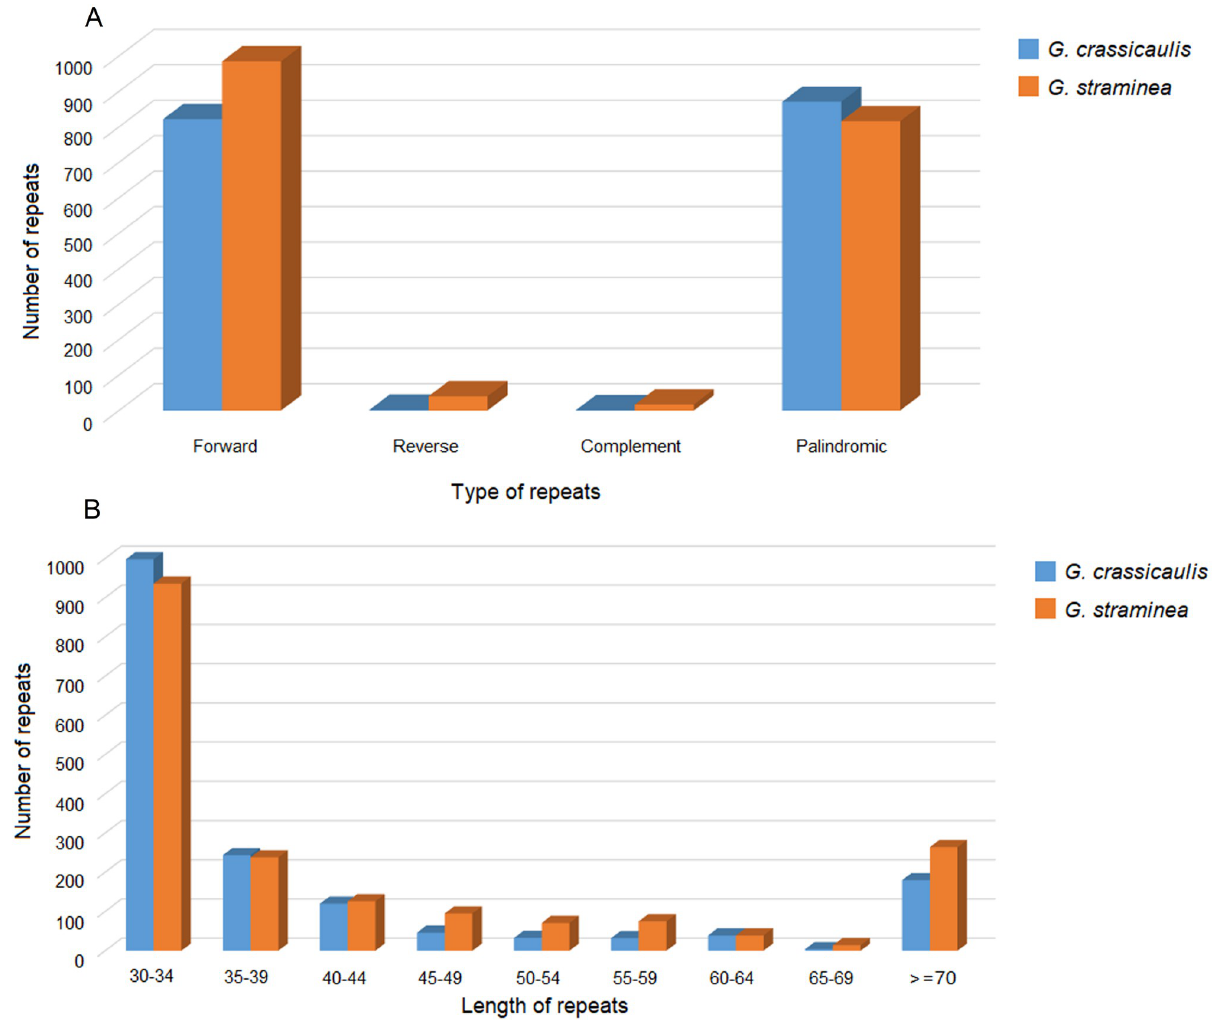
Fig 3. Large repeat sequence characteristics of mitochondrial genomes of Gentiana crassicaulis and G . straminea .